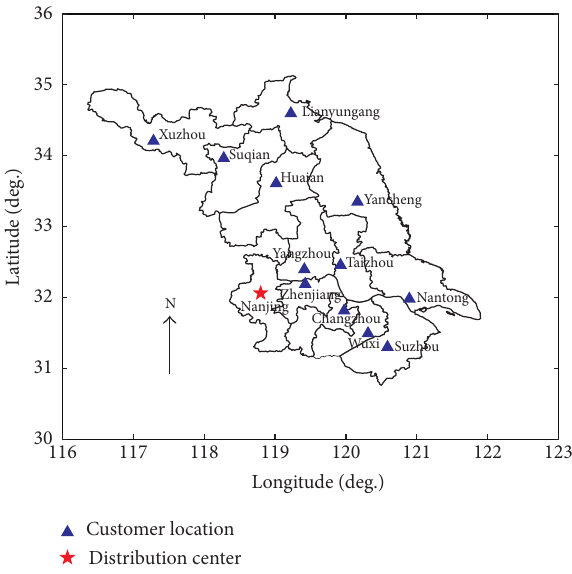
Figure 4: Geographical distribution for distributed cities and distribution center in Jiangsu Province.